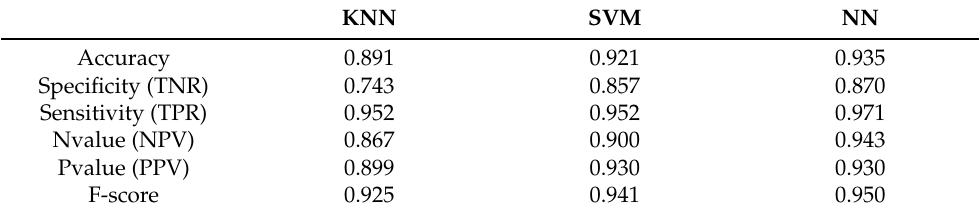
Table 8. Evaluating the results achieved by three baseline machine learning models.